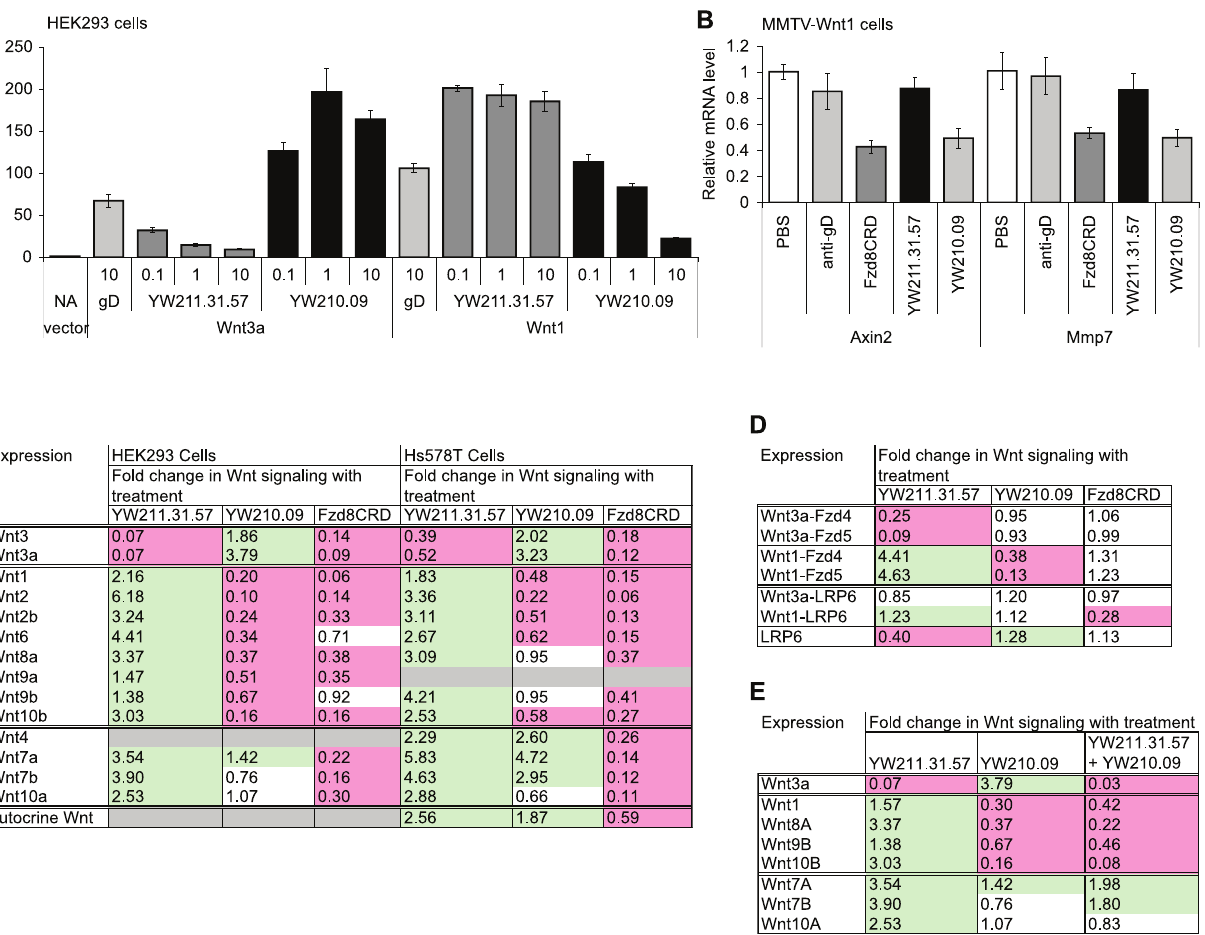
Figure 3. Wnt isoforms specify inhibitory or potentiating activities of LRP6 antibodies. (A) YW211.31.57 antibody antagonizes Wnt3a- induced signaling and potentiates Wnt1-induced signaling, whereas YW210.09 antibody exhibits reciprocal activities. HEK293 cells stably integrated with Wnt and SV40 luciferase reporters were transfected with Wnt3a, Wnt1, or empty vector expression constructs and treated with monoclonal antibodies (mAb). (B) Treatment of cultured cells from mouse MMTV-Wnt1 allograft tumors with 10 m g/ml YW210.09 antibody inhibits expression of Wnt target genes Axin2 and Mmp7, as does 10 m g/ml Fzd8CRD-Fc protein. (C–E) Summary tables of the effects of 10 m g/ml LRP6 antibodies, antibody combinations (E), and Fzd8CRD-Fc protein on signaling induced by transfection of expression constructs for Wnt isoforms (C, E) or chimeric proteins fusing Wnt isoforms to FZD isoforms or LRP6 (D) in HEK293 (C–E) or Hs578T (C) cell lines stably integrated with Wnt luciferase reporters. Expression of Wnt luciferase reporter is normalized to cell number and additionally normalized to levels in cells transfected with the same expression construct but not treated with proteins. The fold change in Wnt signaling is highlighted in red or green to indicate inhibition or potentiation, respectively, with p- value , 0.01 by ANOVA. Gray fields indicate conditions that were not tested because Wnt induction was not